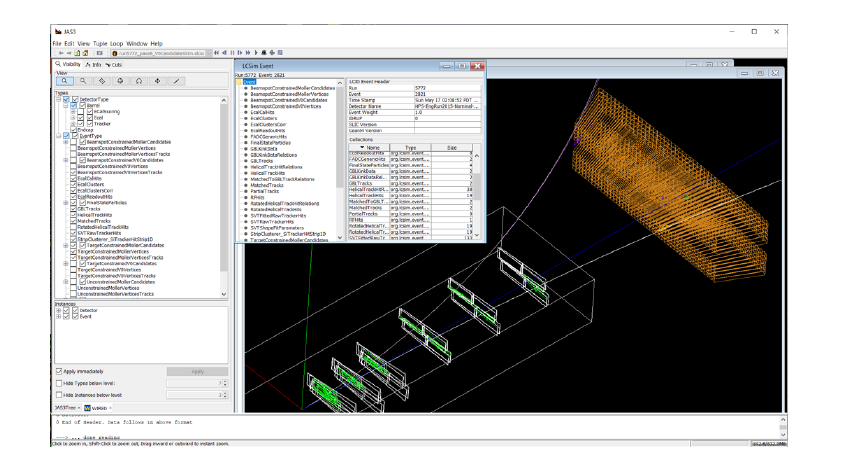
Figure 3. Both the interactive lcsim event browser and Wired4 event display are available as JAS3 plu- gins. Shown is a representative electron-positron pair with tracks reconstructed in the silicon microstrip detector matched to clusters in the electromagnetic